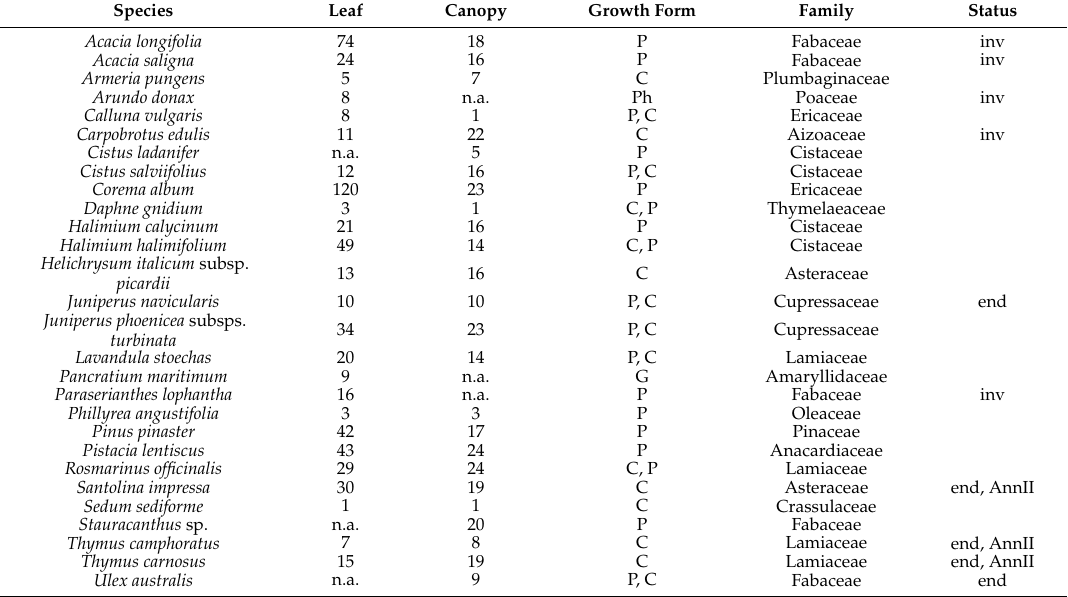
Table 1. Overview of the sampled species including number of sampled leaf spectra, number of sampled canopy spectra, growth form (Chamaephyte (C), Geophyte (G), Phanerophyte (P), Protohemicryptophyte (Ph)), family based on [35] and status (Annex II species of the EU habitat directive, endemic, invasive) based on